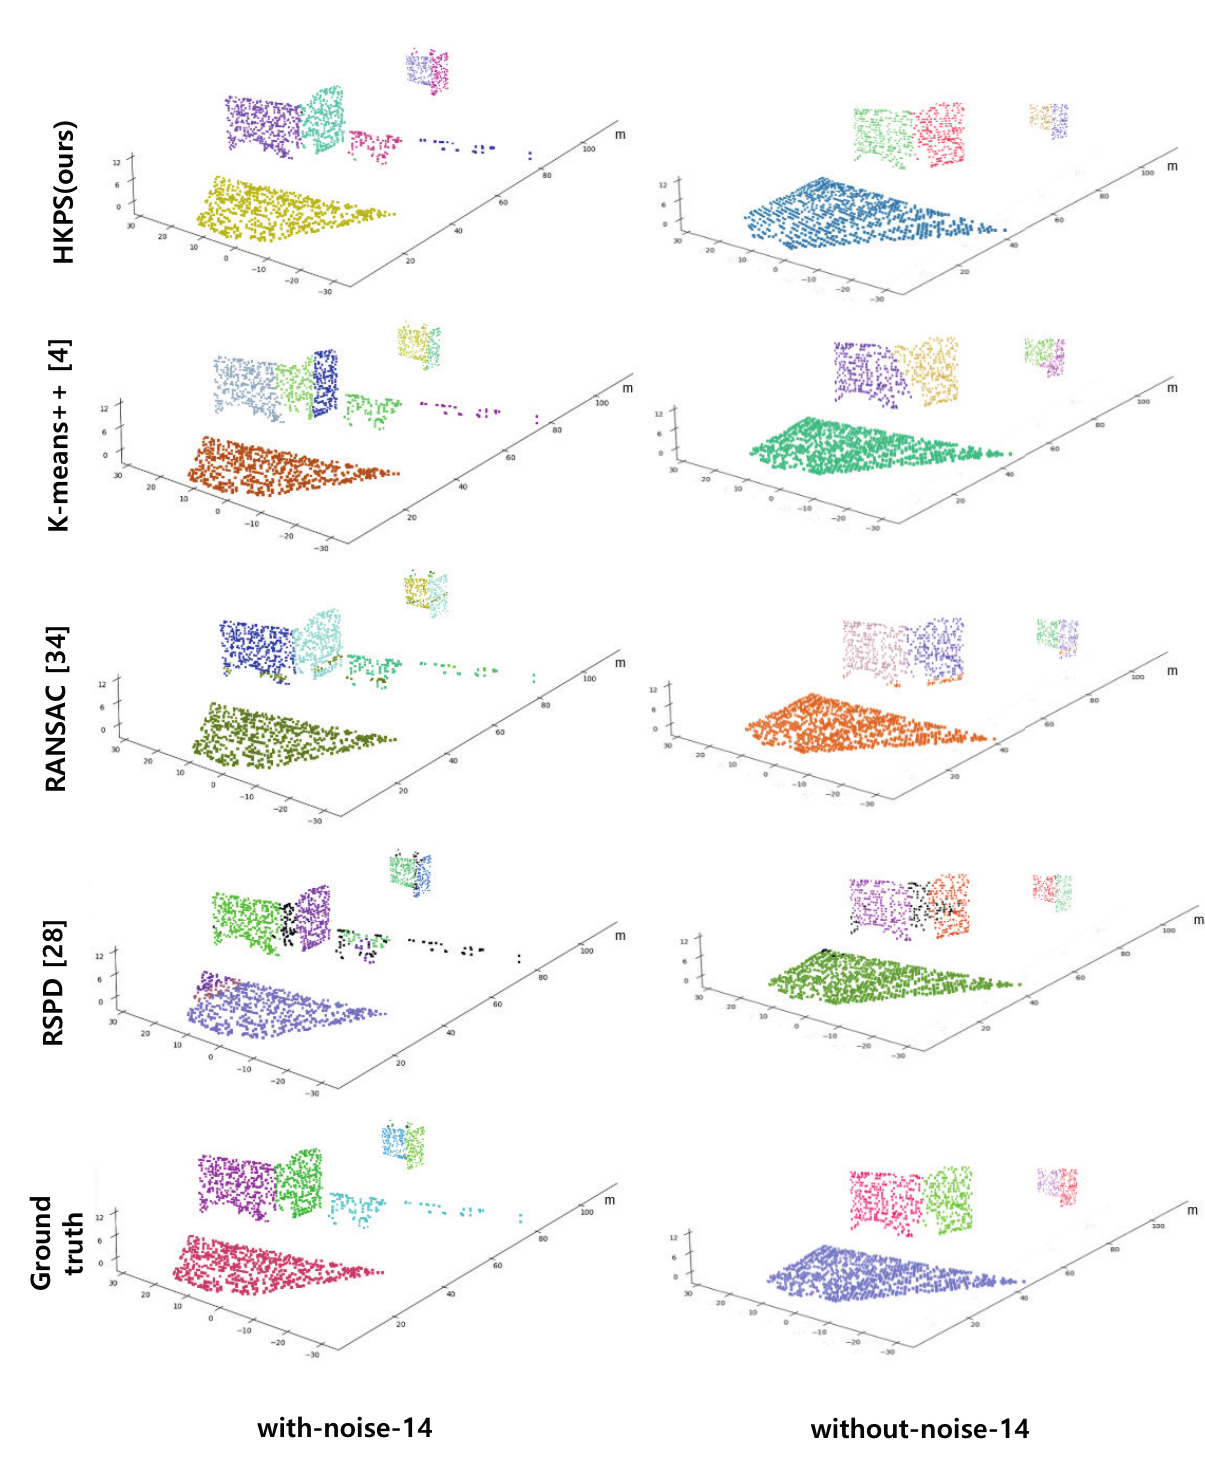
Figure 6. Performance comparison results using scene 14 from with-noise Virtual KITTI Dataset and without-noise Virtual KITTI Dataset. Different planes are displayed with different colors. The outliers of RANSAC and RSPD are colored in